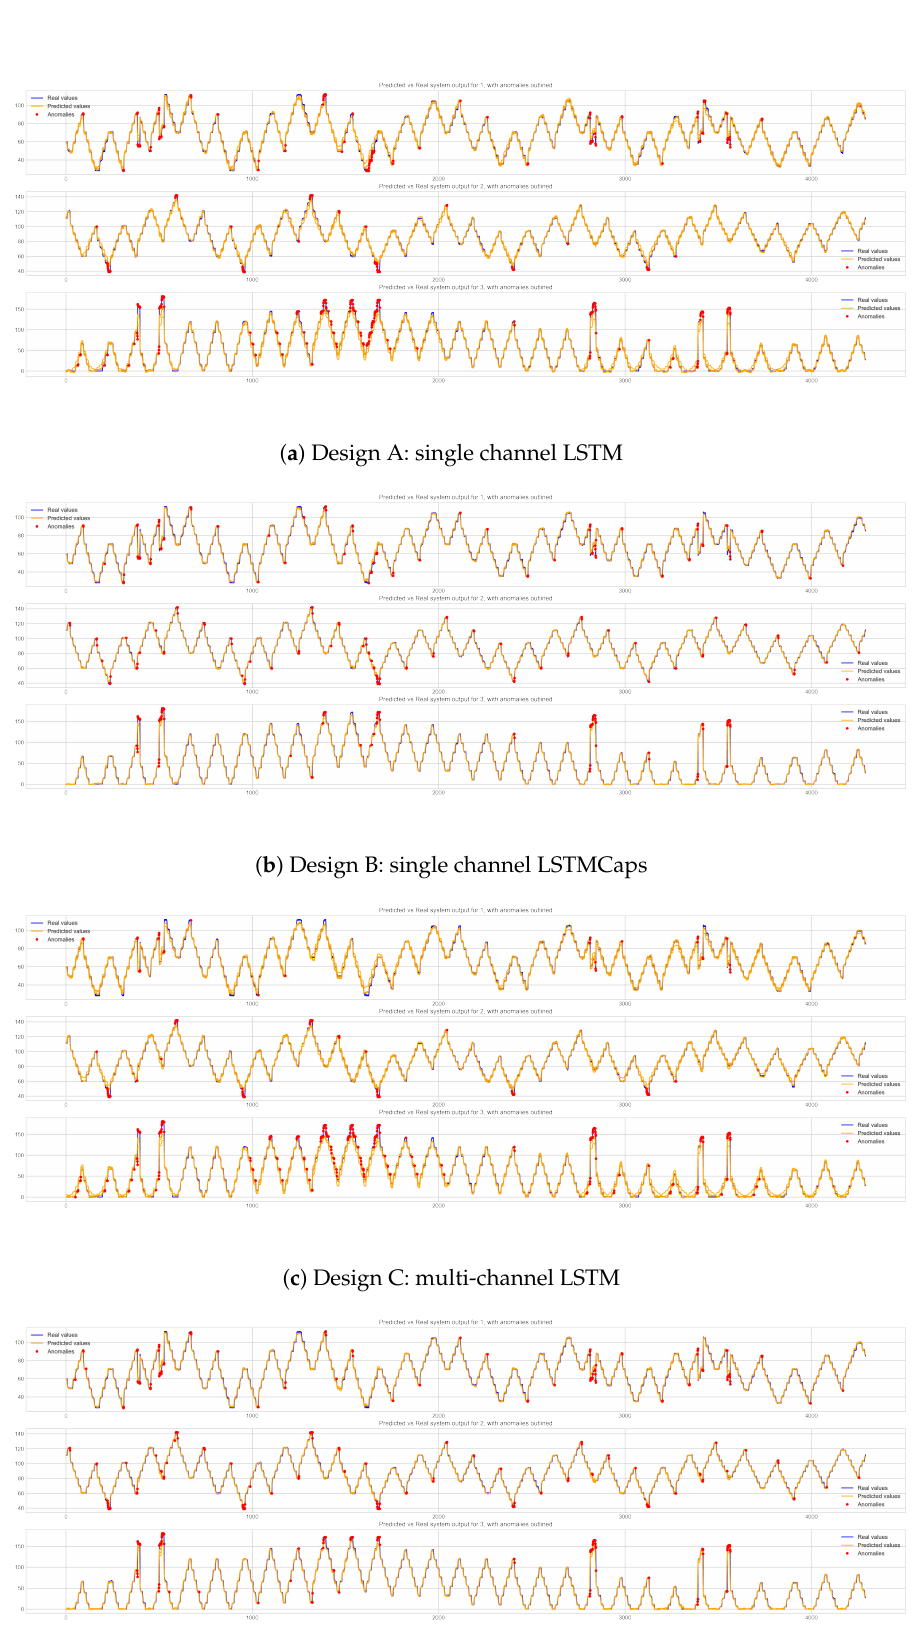
Figure 7. Visualisation of anomalies detected in test data by the best iteration of each